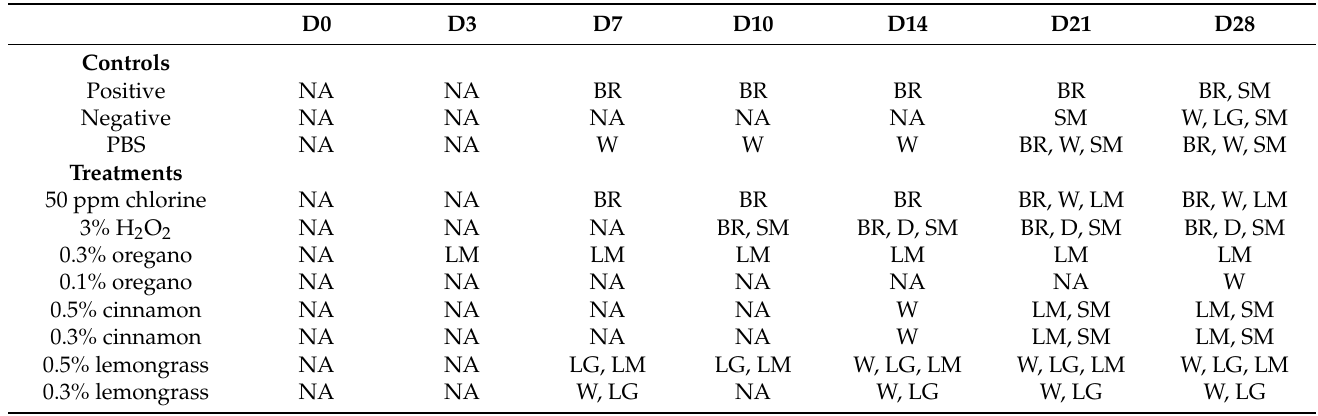
Table 2. Visual observation results of Iceberg lettuce inoculated with P. fluorescens , treated with plant- based microemulsions, 50 ppm chlorine, and 3% hydrogen peroxide and stored for 28 days at 4 ◦